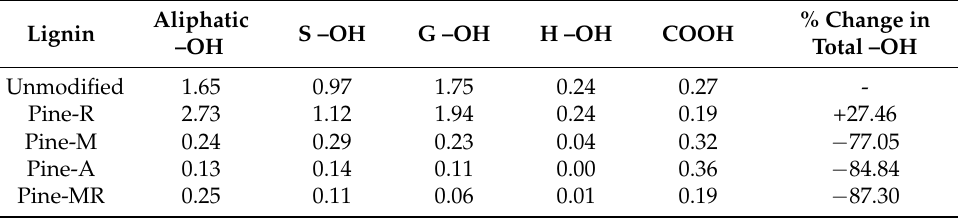
Table 1. Hydroxyl content in mmol/g of pine lignin determined by 31 P NMR spectroscopy. Aromatic hydroxy groups are divided among syringyl (S), guaiacyl (G), and p -hydroxyphenyl (H) moieties.